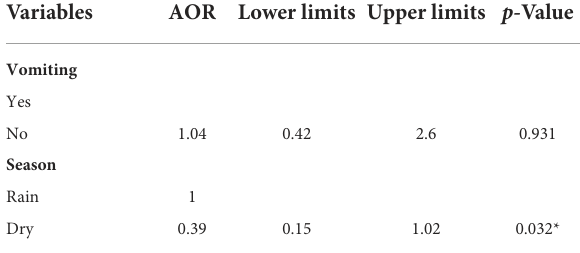
TABLE 3 Bivariate logistic regression for analysis of the factors associated with death among the patients with severe malaria. 95% confidence intervals